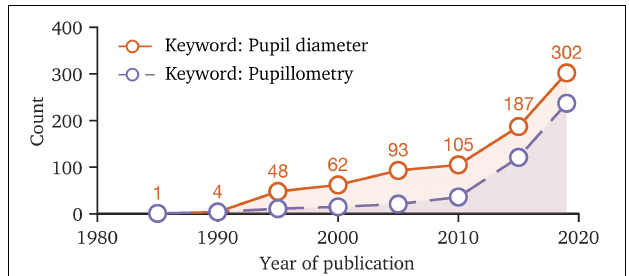
FIGURE 2 | The number of publications with the keywords “pupil diameter” and “pupillometry” since 1985 to 2019, based on the Web of Science database. The rising count of publications in recent years indicates that the topic of pupil behavior is becoming more important. Due to the interdisciplinary field of research, standardization of measurement methodology and data processing is favorable, making study results